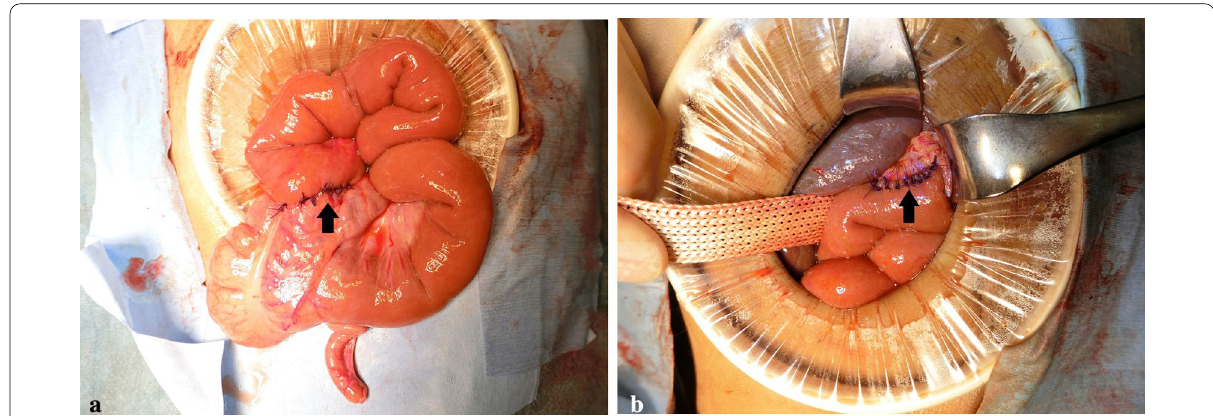
Fig. 2 PIBD using a segment of jejunum (ante-colic) between the gall bladder and ascending colon. A Jejuno-colonic anastomosis (black arrow) B Cholecystojejunal anastomosis (black arrow). PIBD partial internal biliary